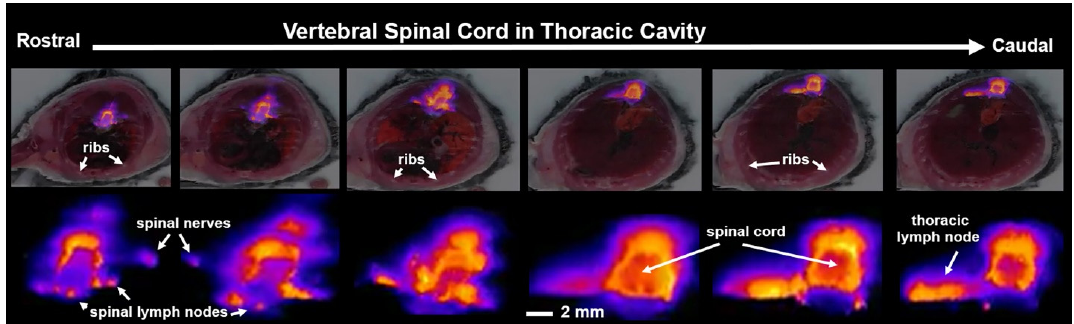
Figure 4. Distribution and clearance along the thoracic spinal cord. Shown above are serial frontal sections of white light anatomy and cryo-fluorescence at the level of the vertebral spinal cord ac- quired 15 min post infusion of Qdots ICV (scale magnified images of the fluorescent signal at each segment of the spinal cord are shown below (scale bar 2 mm). of the spinal cord are shown below (scale bar 2